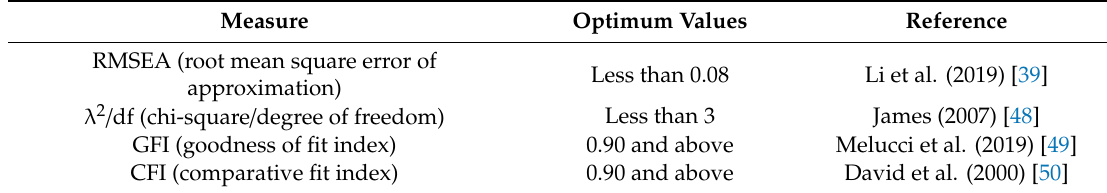
Table 2. Measures used to test the goodness of